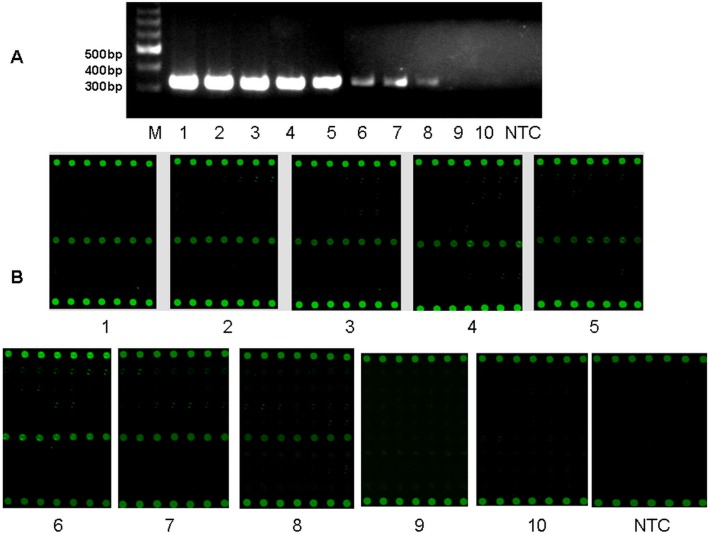
Detection sensitivity of multiplex-PCR-microarray for EVs.The detection sensitivity of the assay was estimated for EVs (EV71) by multiplex RT-PCR and microarray. A. Multiplex RT-PCR result from serial diluted recombinant EV71 control; B. The microarray result after amplification and hybridization. M: 1 Kb DNA ladder; NTC: no template control. Numbers 1–10: Serial 10-fold dilutions of recombinant EV71 control. 1: 6×108copies/μl; 2: 6×107copies/μl; 3: 6×106copies/μl; 4: 6×105copies/μl; 5: 6×104copies/μl; 6: 6×103copies/μl; 7: 6×102copies/μl; 8: 6×101copie/μl; 9: 6×100copies/μl; 10: 6×10–1copies/μl.